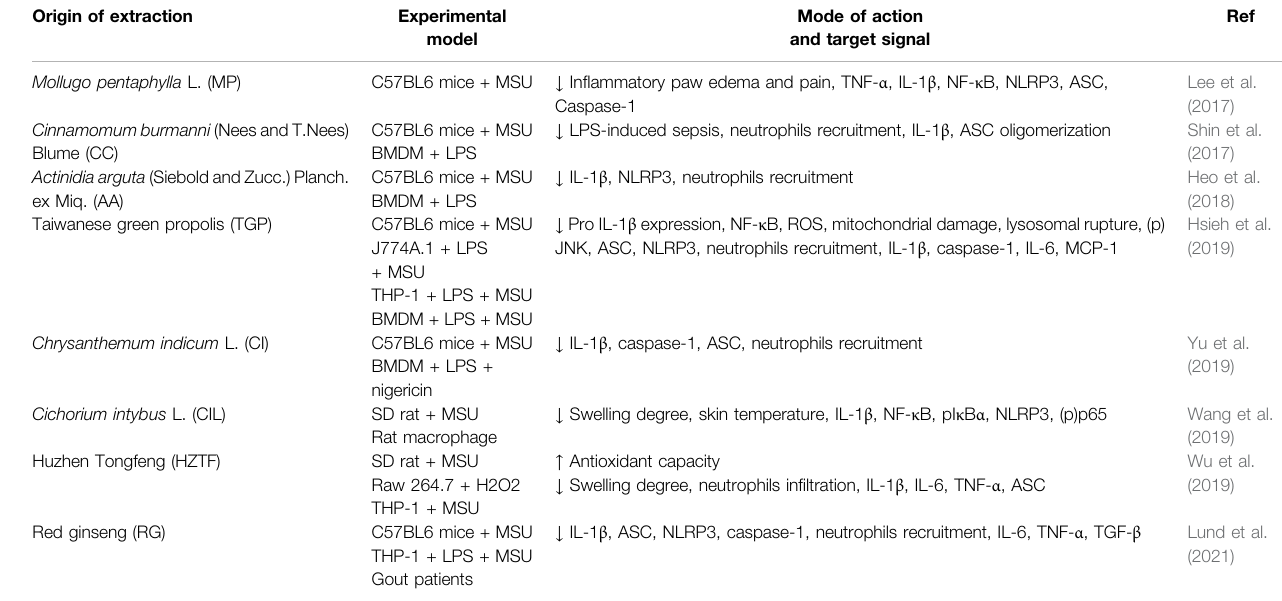
TABLE 1 | Studies regarding natural extracts targeting NLRP3 in fl ammasome in